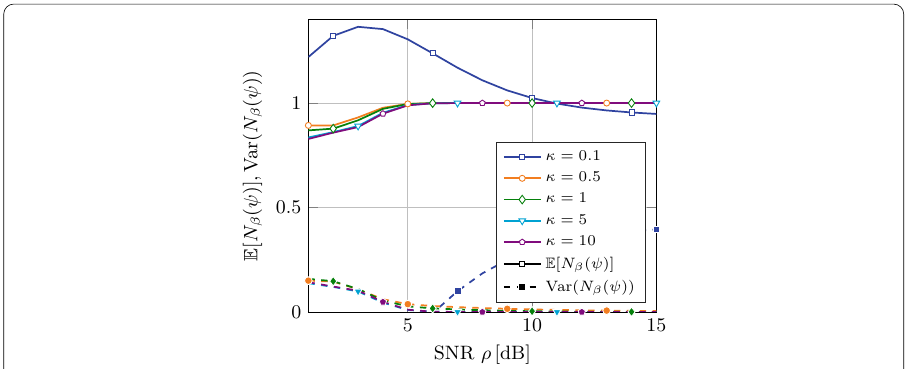
Fig. 9 Expectation and variance of the number of zero-crossings in the TI 5 dB, the expectation of the number of zero-crossings goes to one, while the variance converges to